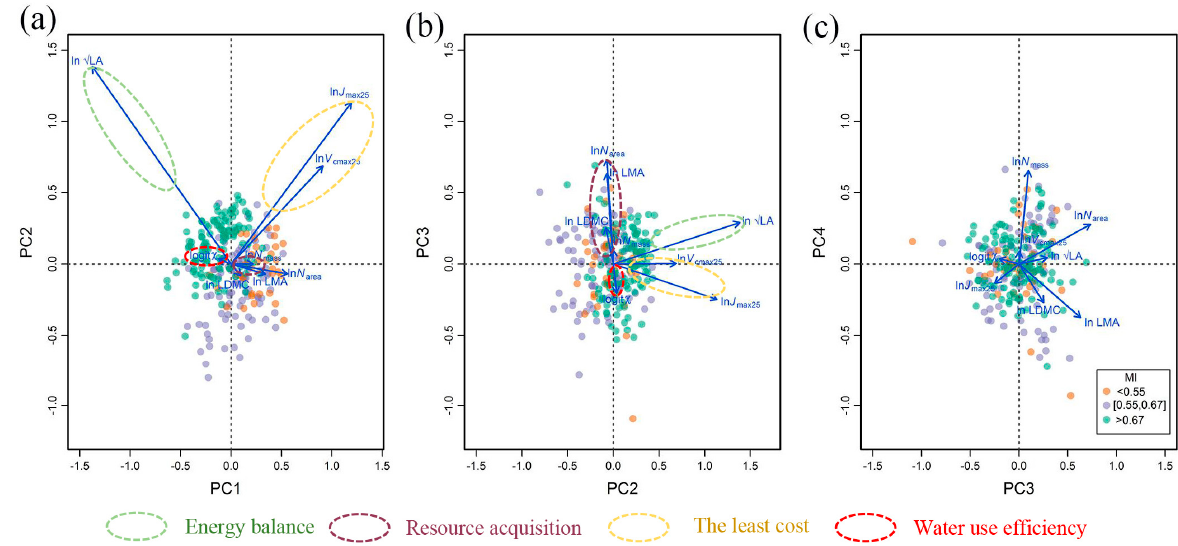
Figure 2. Principal component (PC) patterns of eight plant functional traits. ( a ) PC1 versus PC2. ( b ) PC2 versus PC3. ( c ) PC3 versus PC4. LA: leaf area; N mass : leaf nitrogen content; N area : leaf nitrogen per area; LMA: leaf mass per area; LDMC: leaf dry mass content; V cmax25 : maximum carboxylation rate standardized to 25 °C; J max25 : maximum electron transport rate standardized to 25 °C; χ : ratio of intercellular to ambient CO 2 concentration. Table 2. Trait loading, eigenvalues and percentage of trait variation explained by the first three principal components (PCs). LA: leaf area; N mass : leaf nitrogen content; N area : leaf nitrogen per area; LMA: leaf mass per area; LDMC: leaf dry mass content; V cmax25 : maximum carboxylation rate stand- ardized to 25 °C; J max25 : maximum electron transport rate standardized to 25 °C; χ : ratio of intercel- lular to ambient CO 2 concentration.